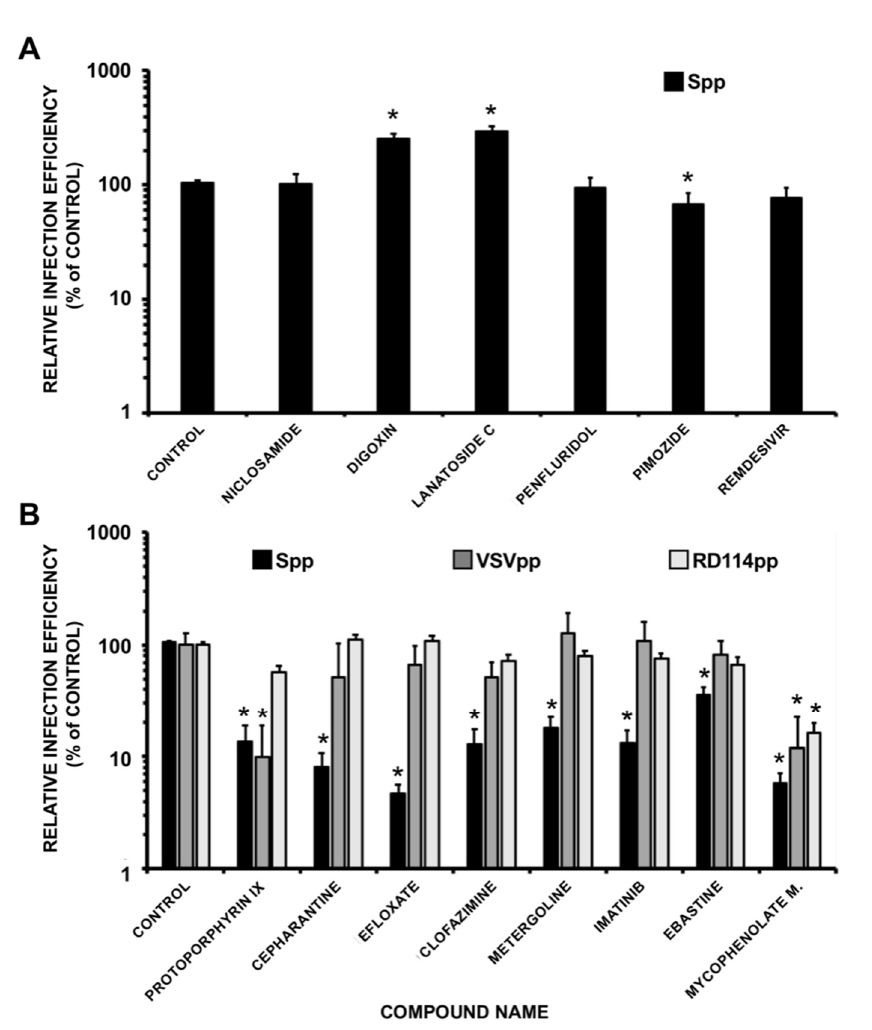
Figure 4. Antiviral candidates interfere with viral entry of SARS-CoV-2 pseudotypes. ( A ) Retroviral vectors pseudotyped with SARS-CoV-2 Spike glycoprotein were used to inoculate Vero-E6 cells in the presence of the candidates at the EC 90 (see Figure 3). Forty-eight hours later, total cell lysates were assayed to determine luciferase activity as a reporter activity for viral entry. ( B ) Compound selectivity was assayed also using VSVpp and RD114pp for the compounds interfering with Spp. Data are shown as average and SEM of a minimum of four biological replicates ( N = 4). Statistical significance was evaluated using a one-way ANOVA and a Dunnet’s post-hoc test (* p < 0.05).